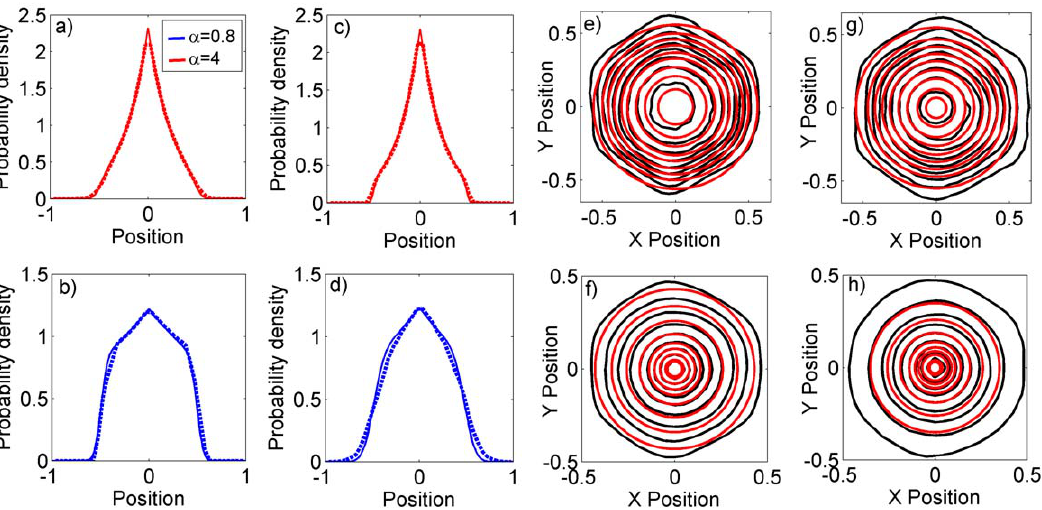
Figure 3. Comparison of the many-bodied simulation system and the reduced analytic model. Saturation marginal probability distributions from simulations of systems of territorial central place foragers are overlaid on the same distributions (equations 8 and 9) from the reduced analytic models. Panels (a–d) compare the two distributions for the 1D system. Dashed lines denote the simulation output and solid lines the analytic approximation. The animal’s central place (CP) is at position 0, whereas CPs of conspecifics exist at positions 2 1 and 1. The distribution decays to 0 at the conspecific CPs, where the animal cannot tread. The values used were (a) k ~ 0 : 0017 , a ~ 4 : 0 , (b) k ~ 0 : 0014 , a ~ 0 : 80 (c) k ~ 0 : 00033 , a ~ 4 : 0 and (d) k ~ 0 : 0040 , a ~ 0 : 80 . Panels (e–g) compare the two distributions for the 2D system. The black contours show the deciles (i.e. 10%, 20%, 30% etc.) of the height of the probability distribution for the simulation system. The red contours show the same quantities for the analytic approximation. The values used were (e) k ~ 0 : 011 , a ~ 0 : 80 , (f) k ~ 0 : 0014 , a ~ 4 : 0 , (g) k ~ 0 : 022 , a ~ 0 : 80 and (h) k ~ 0 : 016 , a ~ 4 : 0 . As we increase k or a , the effect of the adiabatic approximation becomes more apparent, since each red contour is further away from the respective black contour. This is due to the fluctuations of the territory border being more pronounced for higher k or a .